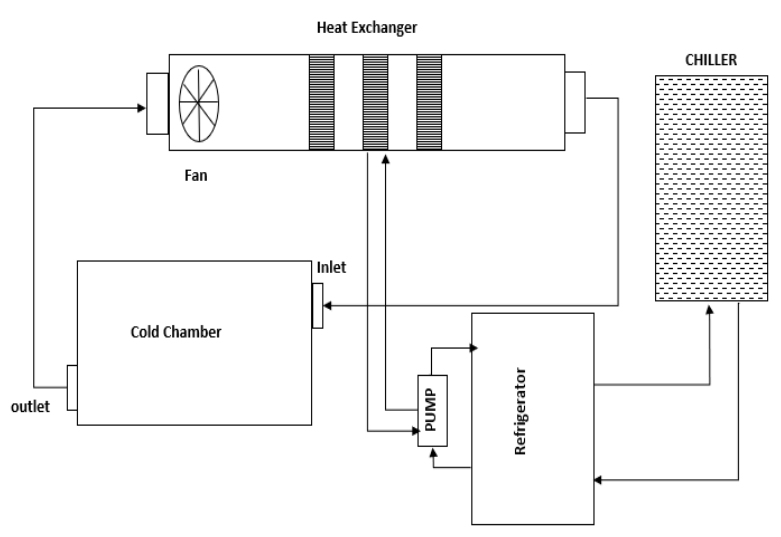
Figure 6. Schematic representation of the laboratory setup used to perform the experiments.